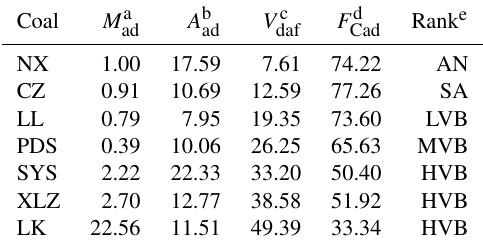
Table 1. Coals used in this study.